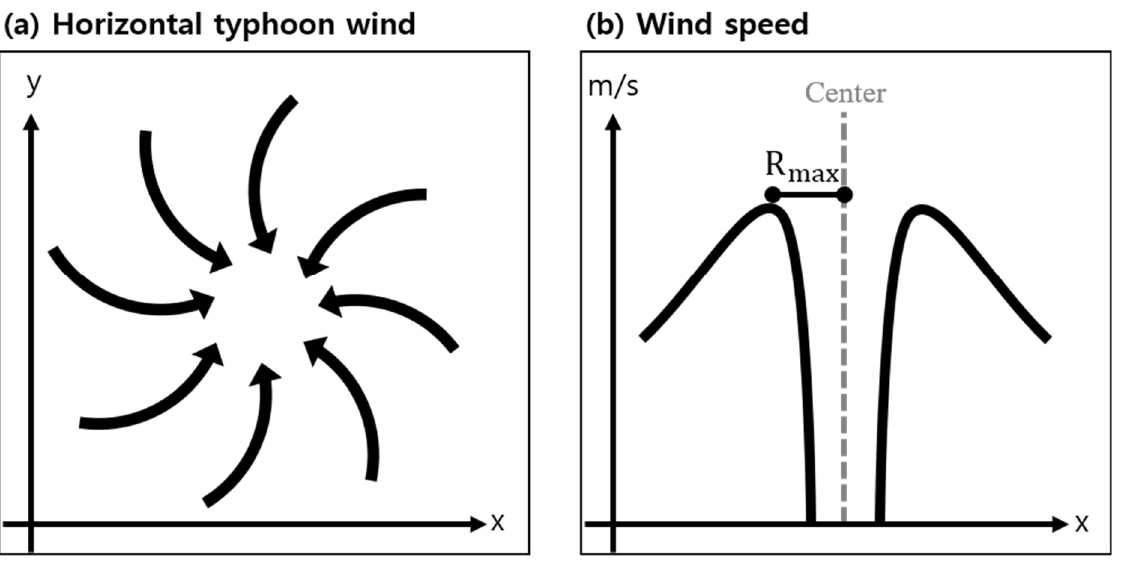
Figure 1. Schematic diagram for the typhoon horizontal wind structures ( a ), and wind speed ( b ). The Rmax can be obtained by direct measurement using an aircraft, estimated from satellite images, and other empirical methods [24–28]. However, for near real-time